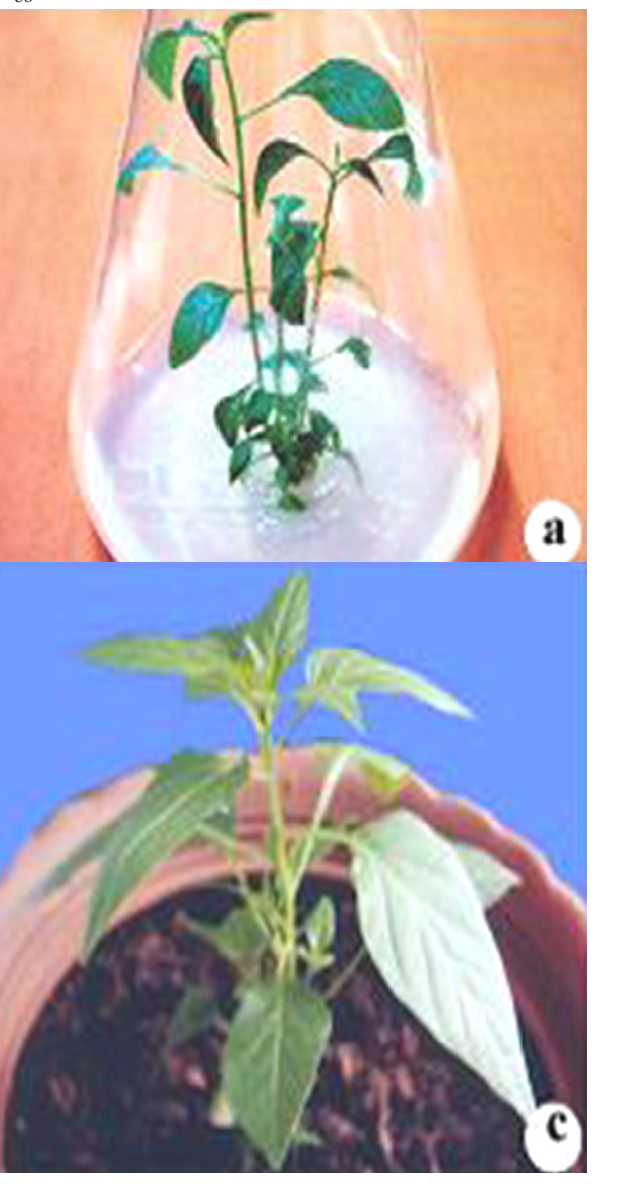
Fig. 1. In vitro shoot bud differentiation on Capsicum annuum L. var. ‘X-235’: (a) Induction of multiple shoot buds from hypocotyl explant; (b) Rooted plantlet; (c) Growth of transplanted plantlet in pot; (d) Fully developed plant with good fruit